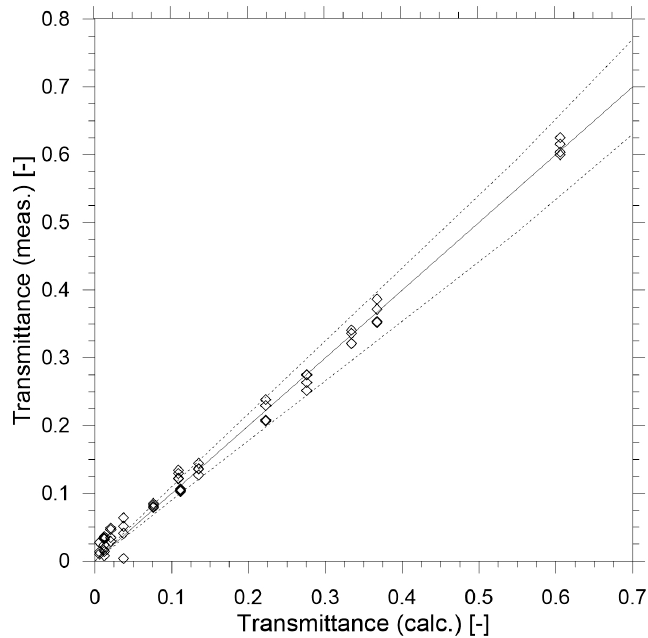
Figure 7. Measured transmittance versus known transmittance value of the calibration filters. Dashed lines represent a 10% difference in measurements.